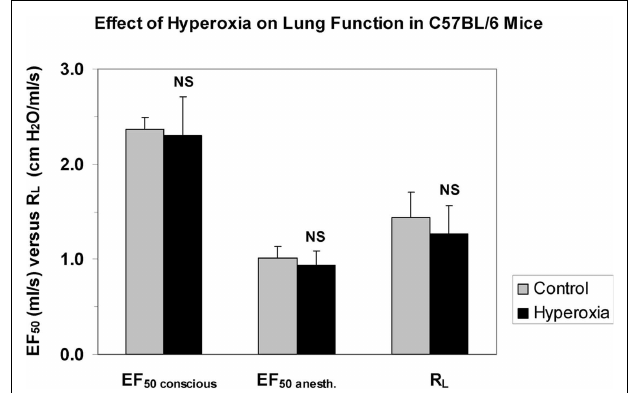
FIGURE 8 | No impact of hyperoxia shows good correlation of invasively and non-invasively measured respiratory parameters in mice (Glaab et al., 2005). Lung function was measured in head-out plethysmographs and subsequently the mice were anesthetized, orotracheally intubated, and lung function was measured invasively.Values are means ± SD of 8 C57BL/6 mice per group exposed to 100% oxygen for 48h or clean air (control). NS, not significant (vs. control group). EF 50conscious : tidal midexpiratory flow of conscious mice, EF 50anesth. : tidal midexpiratory flow of anesthetized mice, R L : lung